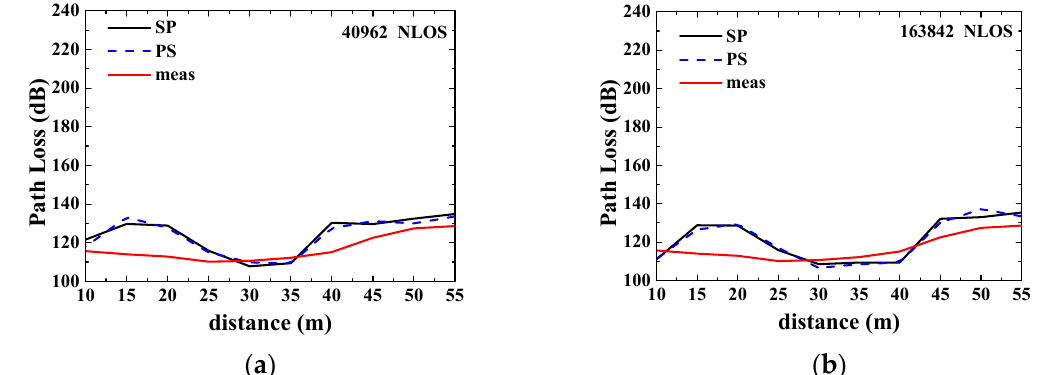
Figure 15. Path loss comparison of theoretical calculation with measured data for 40,962 and 163,842 rays in the NLOS. ( a ) The number of rays is 40,962 ( b ) The number of rays is 163,482.